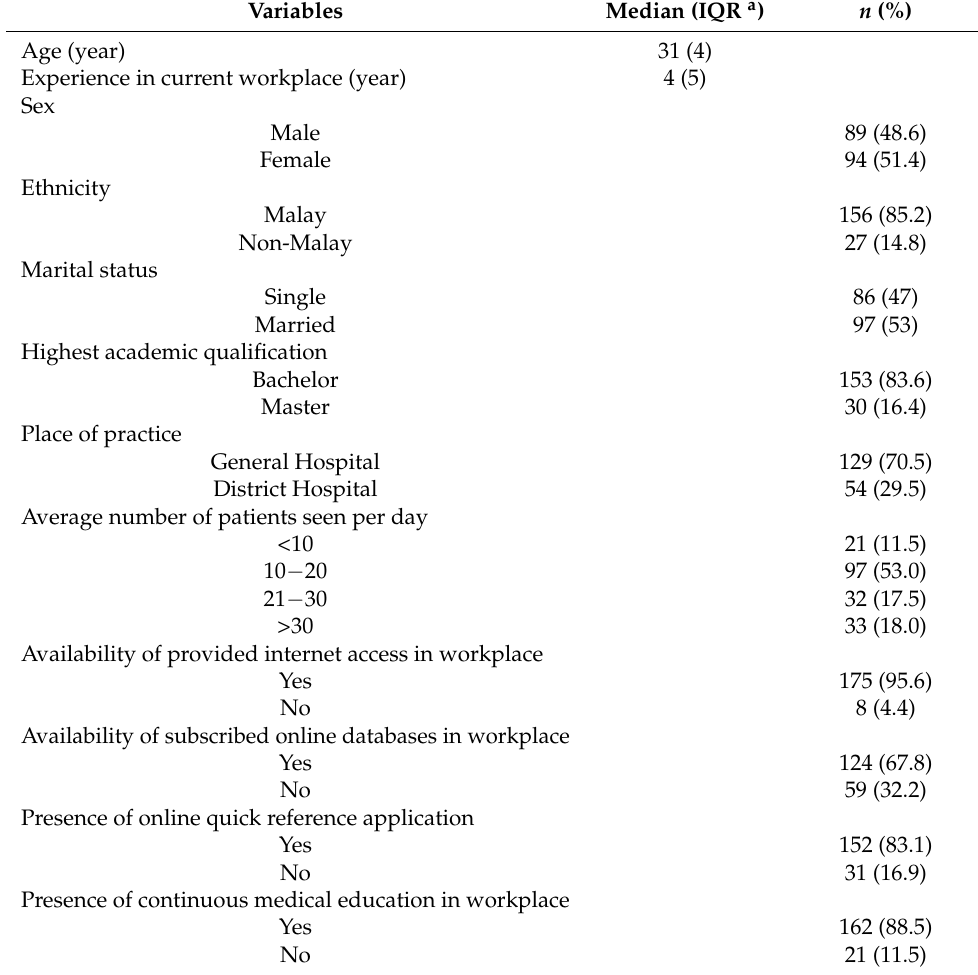
Table 1. Characteristics of the study respondents ( n =